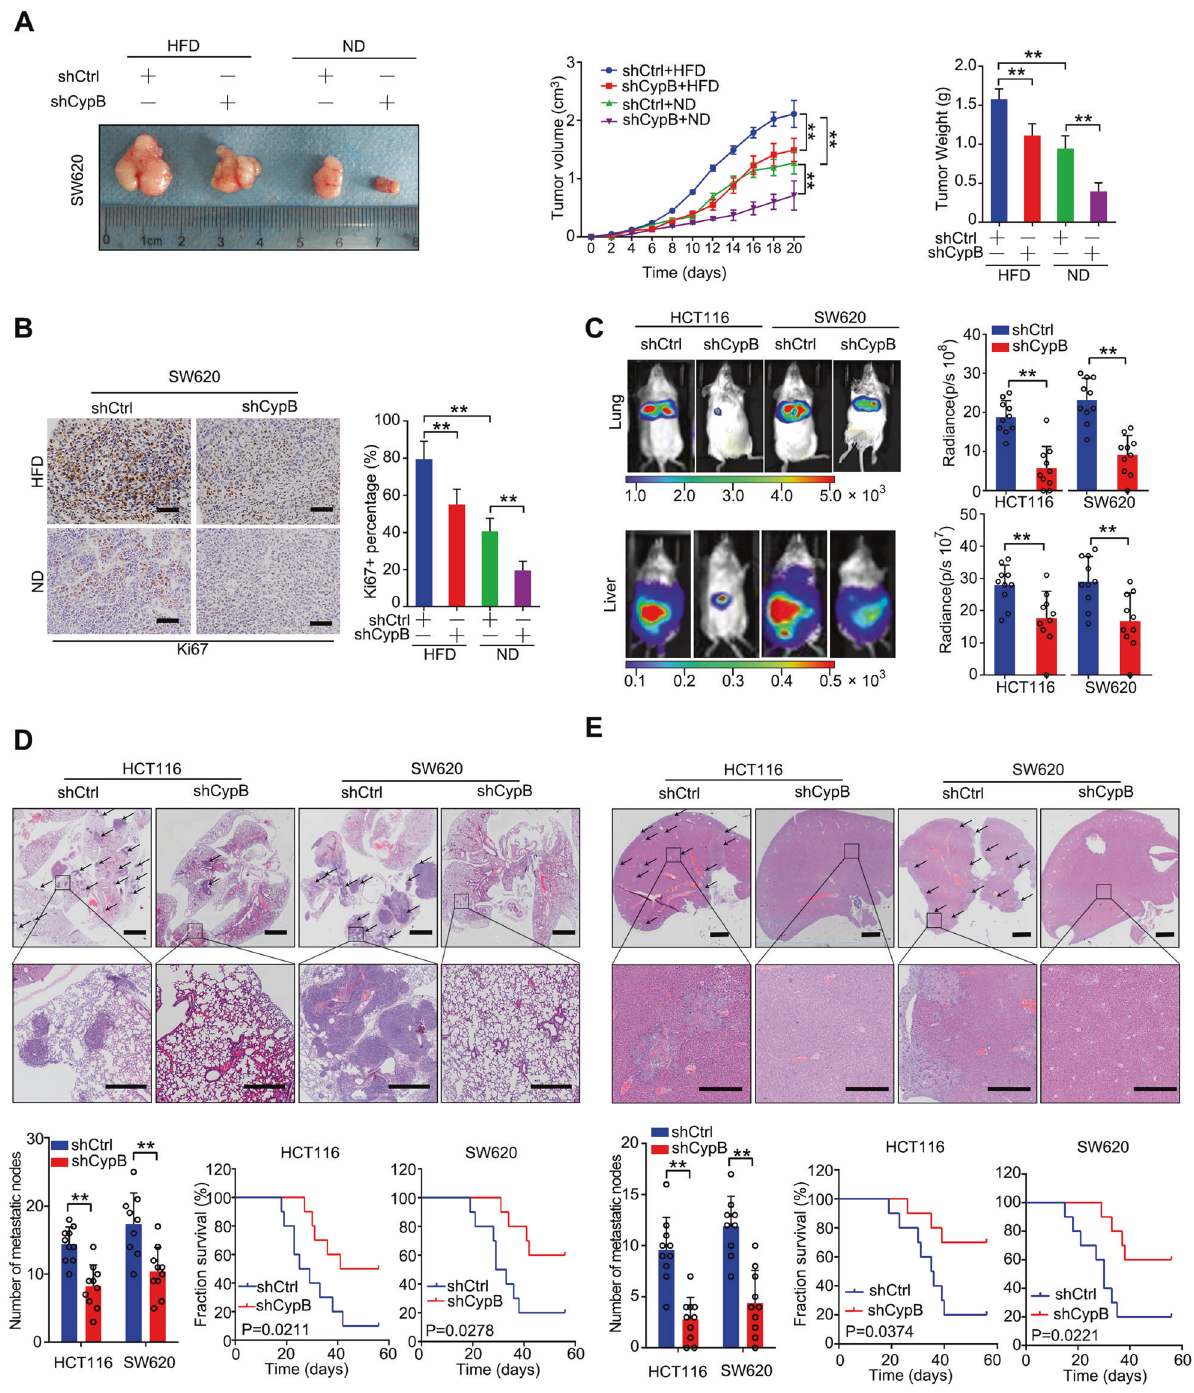
Fig. 3 CypB increases CRC cell growth, invasion and metastasis in vivo. A Left: Representative images of tumors from SCID mice xenografted with SW620 cells infected with lentiviral shCypB or shNC vectors, with normal diet (ND) or high fat diet (HFD) ( N = 5). Middle: Volume of xenografted tumors derived from SW620 cells. Right: tumors weight of different groups. B Left: Representative images of tumor samples that were stained via IHC for Ki-67 staining. Right, the percentages of Ki-67-positive cells. Scale bar: 100 μ m. C Top: Representative bioluminescent images and radiance levels of lung metastasis in the different groups at 8 weeks after tail vein injection ( N = 10). Bottom: Representative bioluminescent images and radiance levels of liver metastases in the different groups at 8 weeks after intrasplenic inoculation. D Representative haematoxylin and eosin (HE) staining showing metastatic nodules in lung tissues of SCID mice ( N = 10). Scale bar: 2 mm (upper); 500 μ m (lower). Arrows show metastatic nodes of tumors. Bottom: Left, number of metastatic nodes in different groups. Right, overall survival times of the SCID mice in the different groups. E Representative HE staining showing metastatic nodules in liver tissues of SCID mice ( N = 10). Scale bar: 2 mm (upper); 500 μ m (lower). Bottom: Left, number of metastatic nodes in different groups. Right, overall survival times of the SCID mice in different groups. The data are presented as the means ± SDs. * P < 0.05; ** P < 0.01; N.S. not signi fi